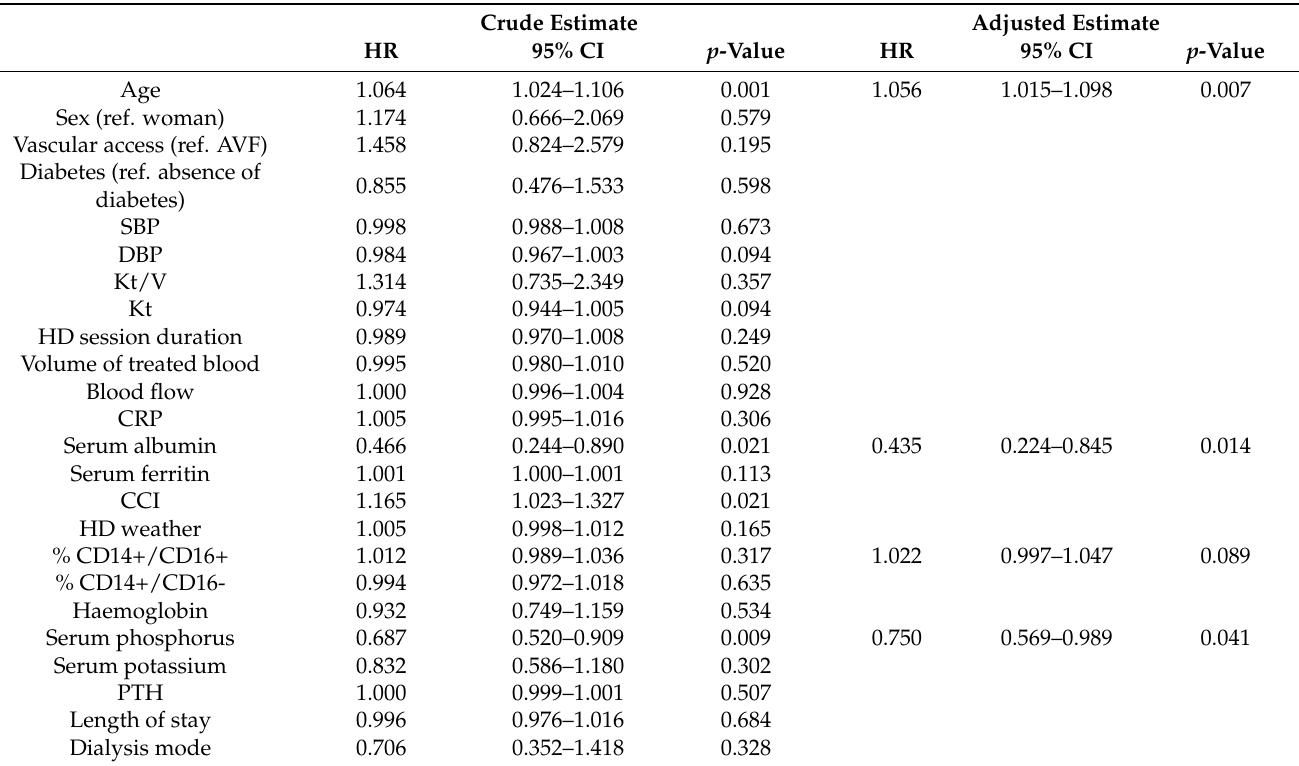
Table 5. Cox regression: crude and adjusted estimates for the study